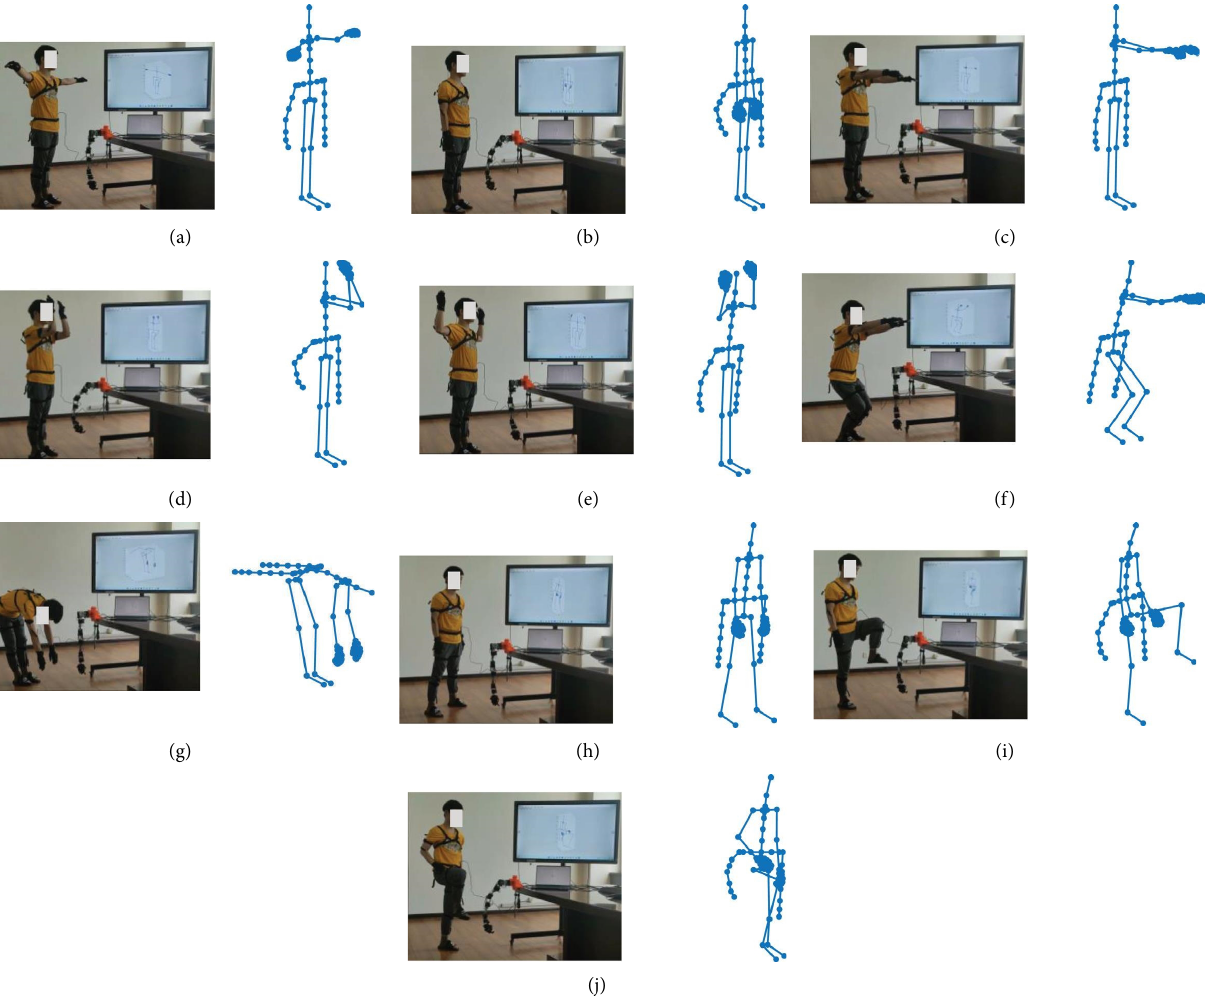
Figure 14: Video screenshots of the visualization test of the human-SRL skeleton movement and the corresponding skeleton diagrams for these